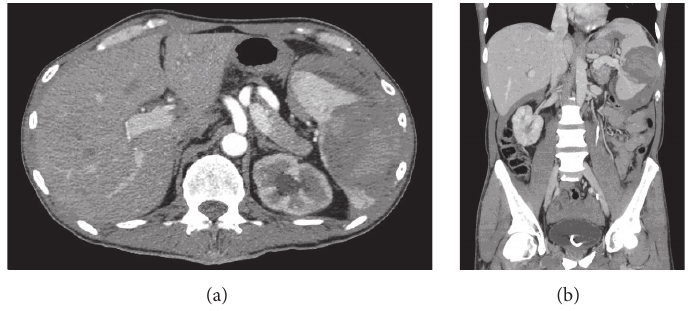
Figure 1: Axial CT scan demonstrating splenic bleeding (a); coronal scan